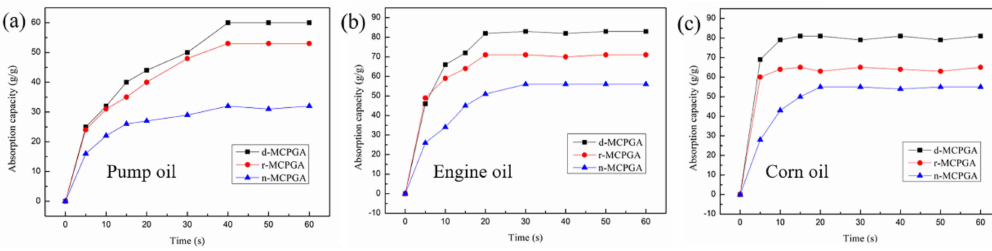
Figure 12. The absorption capacity of MCPGA (d-MCPGA, r-MCPGA, n-MCPGA) to adsorb ( a ) pump oil; ( b ) engine oil and ( c ) corn oil as a function of